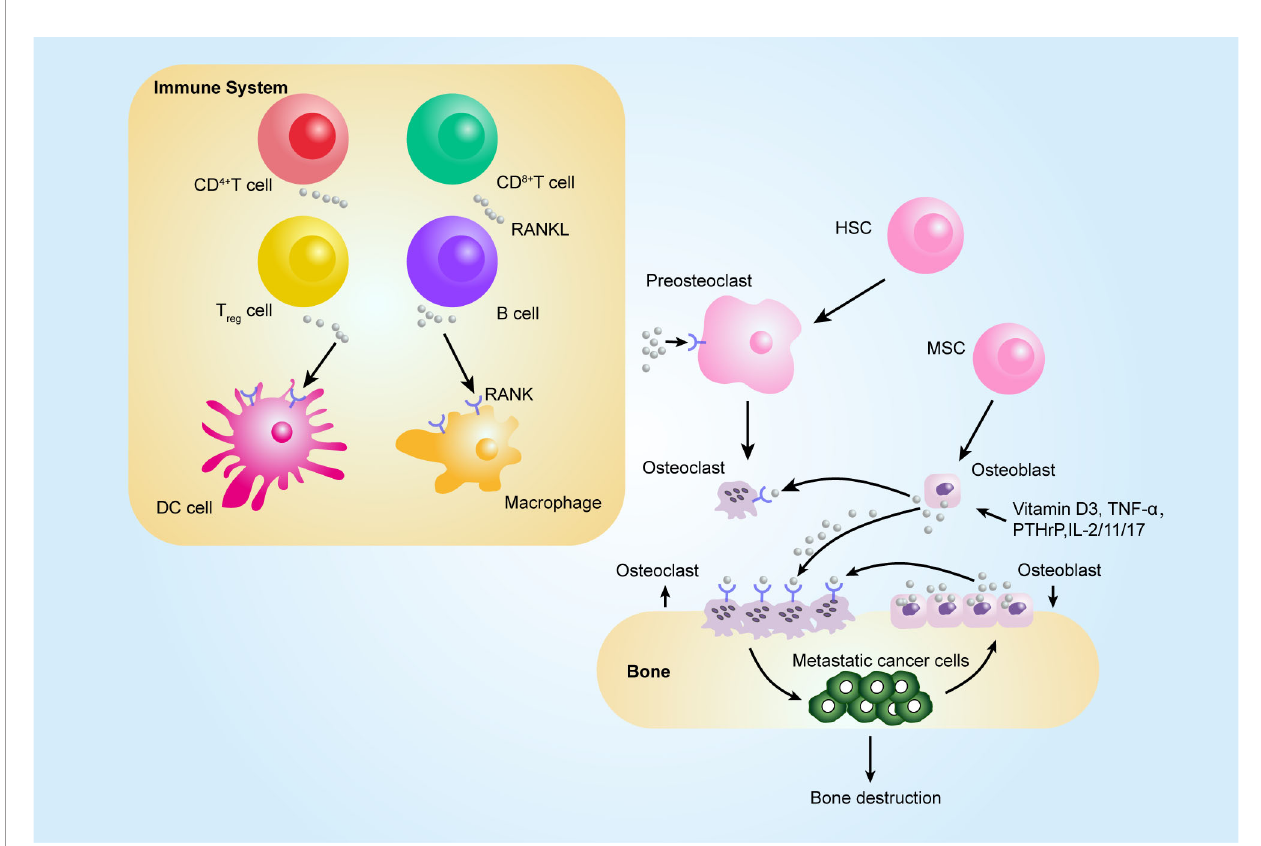
FIGURE 2 | Contribution of the RANKL – RANK axis in immune system and bone metastasis. Among tumor-in fi ltrating immune cells, the expression of RANKL has been observed on all immune cell types, such CD8+ T, CD4+ T, and Treg cells, and RANKL can act on dendritic cells (DCs) to promote their survival and to prolong T – DC interactions. Bone-resorbing factors, such as vitamin D3, PTHrP, IL-1, IL-11, IL-17, and TNF- a , act on osteoblasts to induce RANKL, which binds to RANK present at the surface of osteoclast progenitors (pre-osteoclasts), which results in bone resorption by mature osteoclasts. The fi gure was designed using Adobe Illustrator